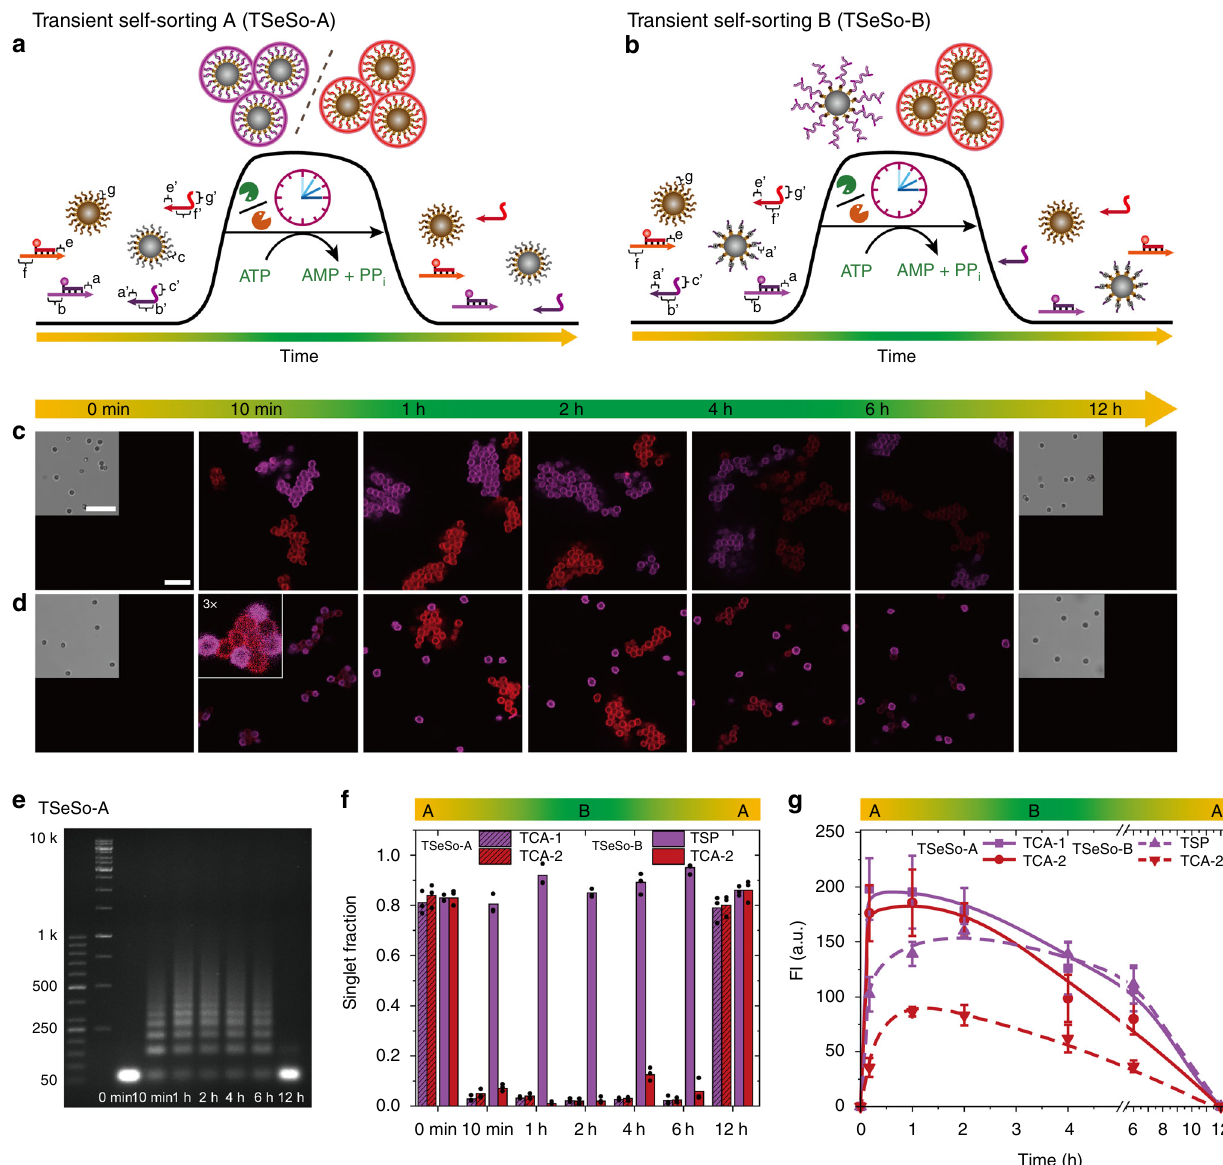
Fig. 6 ATP-fueled transient self-sorting (TSeSo) on a multicomponent systems level. a , b Schemes representing two different self-sorting multicomponent colloidal systems. c CLSM of two ATP-fueled colloidal assemblies, TSeSo-A, operating in the same systems in parallel. Scale bar = 5 μ m; insert = 10 μ m. d CLSM of TSeSo-B, whereby one colloid species is driven into assembly (TCA), while the other species is encapsulated (TSP). e Time- dependent AGE of the SfNAPs formed in TSeSo-A. f Time-dependent singlet fraction of both self-sorting systems. Points correspond to analysis at random places. g Fluorescence intensity of the colloids with time for both self-sorting systems. Lines are guides to the eye. Error bars are standard deviations of 50 colloids. Conditions for a : 10.0 μ M dsDNA 1 -Cy3, 12.0 μ M ssDNA 1 , 10.0 μ M dsDNA 2 -ATTO 647, 12.0 μ M ssDNA 2 , 0.92 WU μ L − 1 T4 DNA ligase, 1.0 U μ L − 1 BsaI, ca. 0.1 mg mL − 1 DoS 1 modi fi ed colloid, 0.1 mg mL − 1 DoS 2 modi fi ed colloid, 83.3 μ M ATP, 37 °C. Conditions for b : The same condition as a except